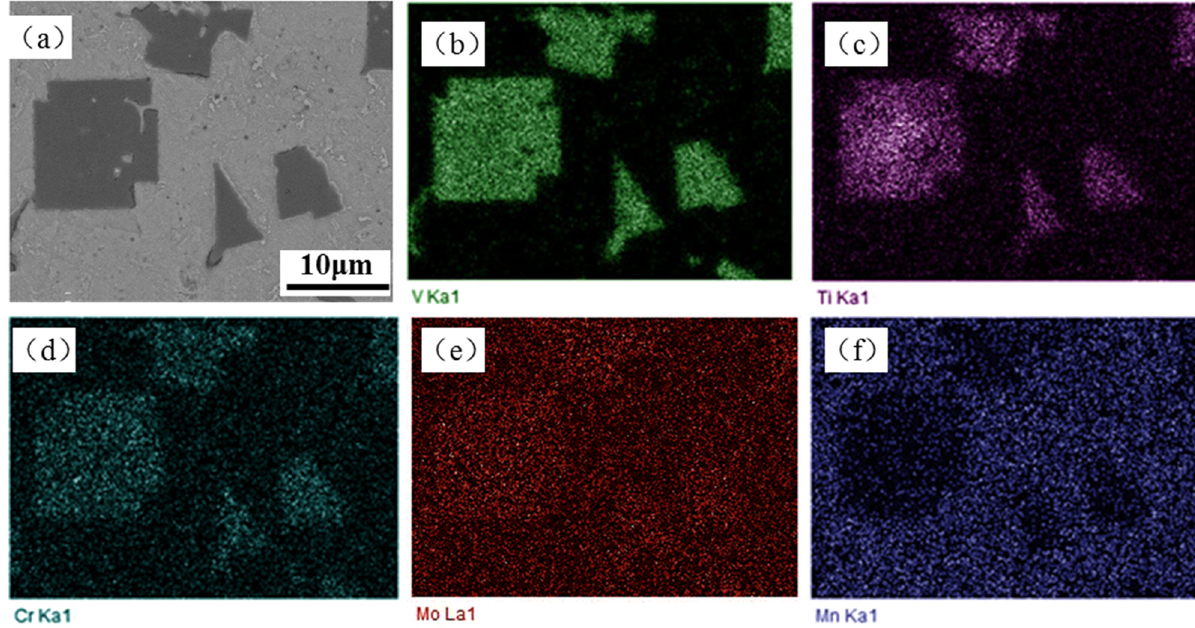
Figure 5: Elemental maps of A1 alloy for 5,400 s partitioning time: ( a )- SEM - BSE image and EDX map for ( b ) V, ( c ) Ti, ( d ) Cr, ( e ) Mo, and ( f ) Mn.